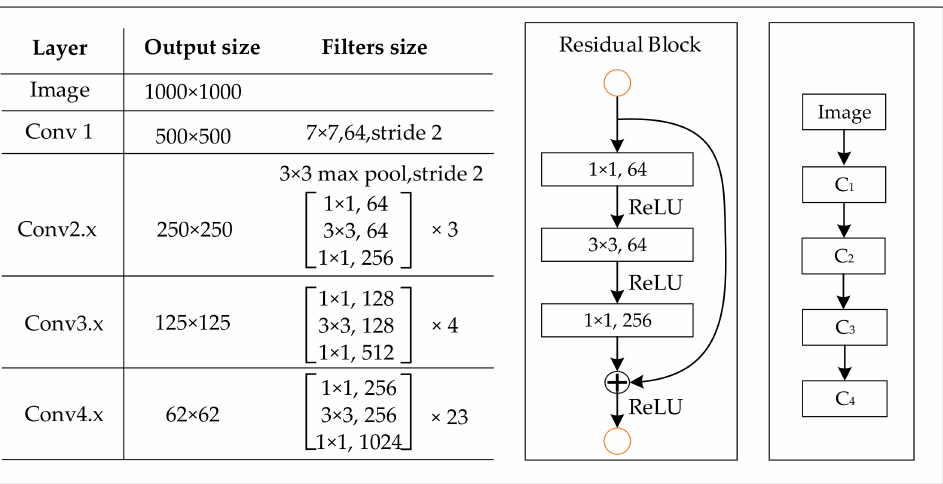
Figure 3. TRDet network architecture: TRDet consists of two phases: feature extraction and rotation branch. In the feature extraction phase, multiple levels’ abundant features are extracted and integrated by DFF-Net and PAM. Then, RPN generates a series of horizontal anchors, the ROI Align to align features, and the GAP to replace the fully connected layer. By Combining the above predictions, R-NMS produces the final detection results.